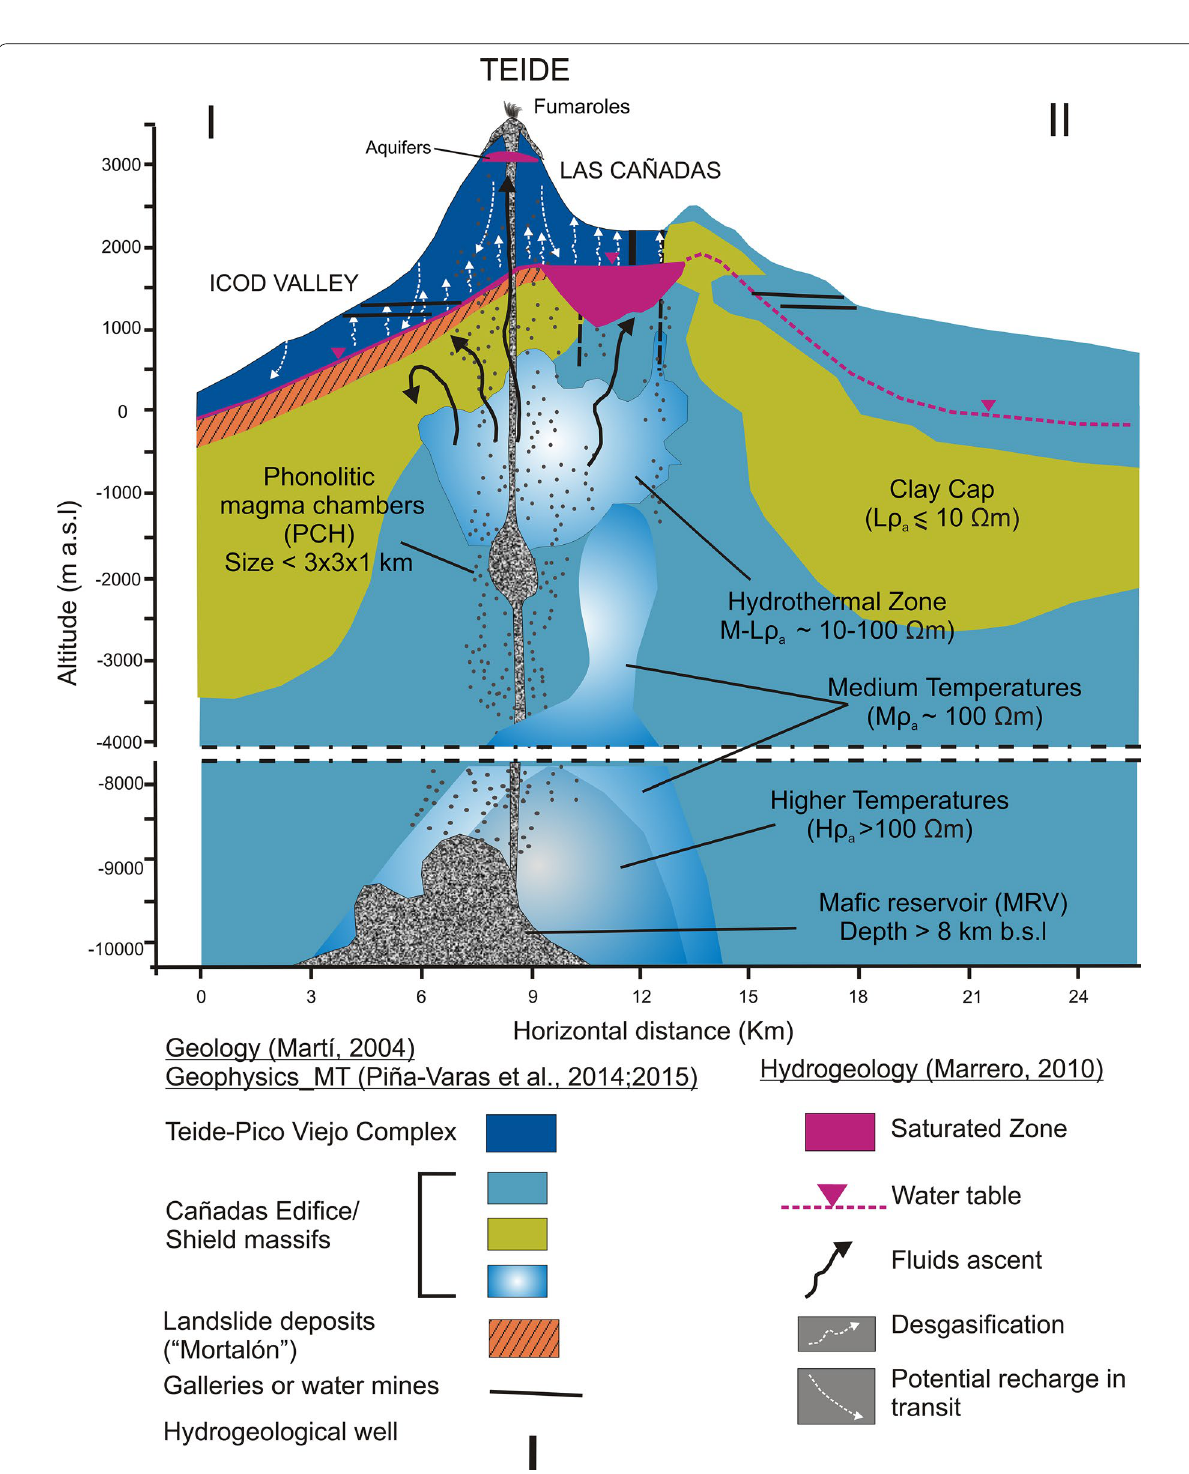
Fig. 5 Hypothetical model of Tenerife volcanic system. The background model corresponds to the geological scheme proposed by Martí (2004) to explain the origin of Las Cañadas Caldera by vertical collapse (see Fig. 1 for location of the profile I–II). The resistivity values (in Ωm) are overlap‑ ping the geological scheme providing valuable information about the hydrothermal alteration products (clay cap). The location of the phonolitic chambers beneath the Teide is based on the petrological studies (Andújar et al. 2013), while its size is constrained by the results obtained in this work. The depth of the mafic reservoir is determined from the results obtained in this study, for a large‑scale magma chamber as that proposed by De Barros et al.